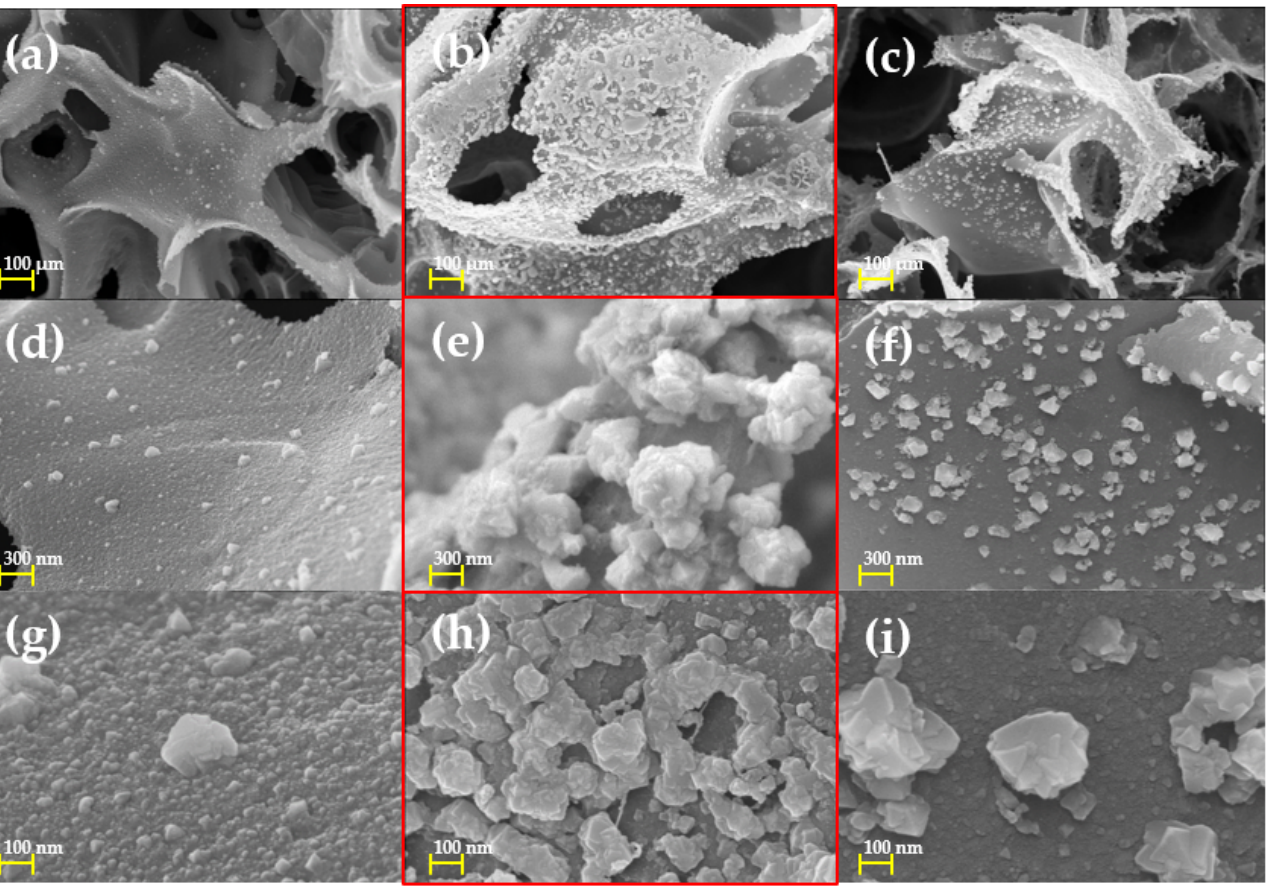
Figure 2. FE-SEM images of Cu/LIG patterns fabricated with varying amounts of Cu solution: ( a , d , g ) 2.5 μL; ( b , e , h ) 5 μL; ( c , f , i ) 7.5 μL. ( a , d , g ) 2.5 µ L; ( b , e , h ) 5 µ L; ( c , f , i ) 7.5 µ